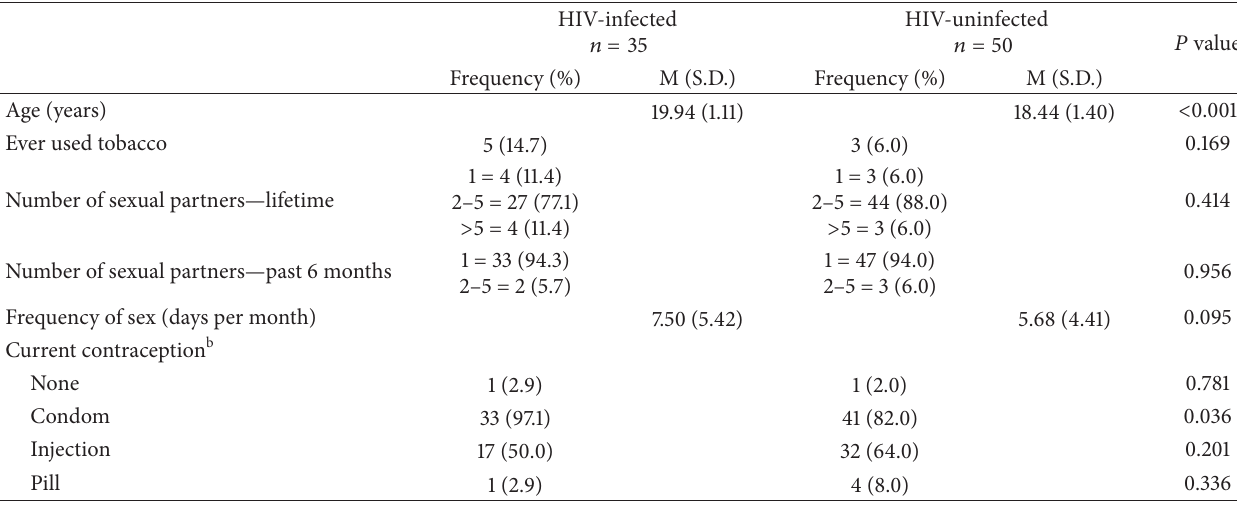
a Percentages in table are based on nonmissing data. b Percentages exceed 100% because many participants use more than one contraceptive